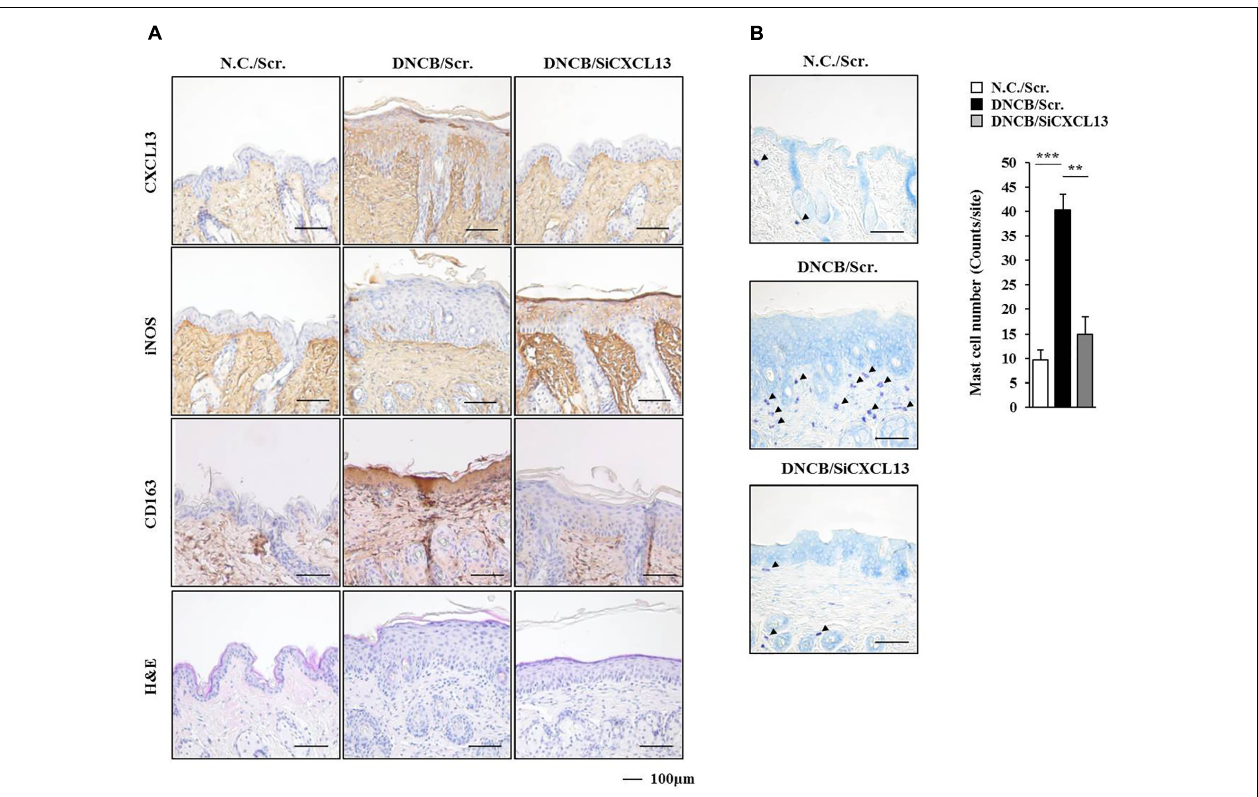
FIGURE 11 | DNCB-induced AD regulates the expression of markers of activated macrophages. (A) Immunohistochemical staining by employing the indicated antibody was performed. Scale bar represents 100 µ m. Skin tissues of BALB/c mice of each experimental group were isolated at the time of sacrifice and were also subjected to H&E staining. (B) Toluidine blue staining was performed to determine the number of degranulated mast cells. Closed triangle represents degranulated mast cells. ∗∗ p < 0.005; ∗∗∗ p <